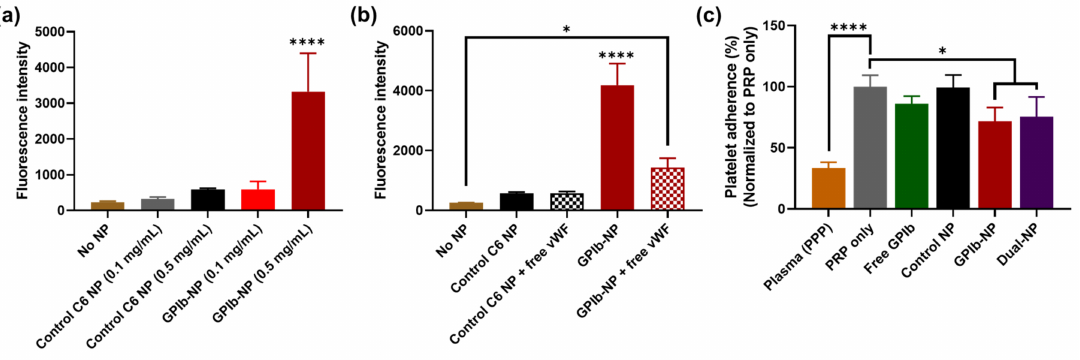
Figure 5. In vitro targeting efficiency of GPIb-NPs to vWF and prevention of platelet adherence to vWF-coated surface. ( a ) Fluorescence intensity (a.u.) of GPIb-NPs adhering on vWF-coated surfaces. Data are presented as mean ± SD ( n = 6). ( b ) Binding competition of GPIb-NPs to vWF-coated surface in the presence of free vWF as determined by fluorescence intensity (a.u.). C6-loaded NPs (C6 NP) served as control NPs. ( c ) The percentage of platelet adherence to vWF-coated surface in the presence of different NP samples quantified by LDH assays, which was determined at absorbance at 490 nm, then normalized to the PRP-only group. Platelet-poor-plasma (PPP) and PRP only served as negative and positive controls, respectively. Data are presented as mean ± SD ( n = 3). * p < 0.05 and **** p <